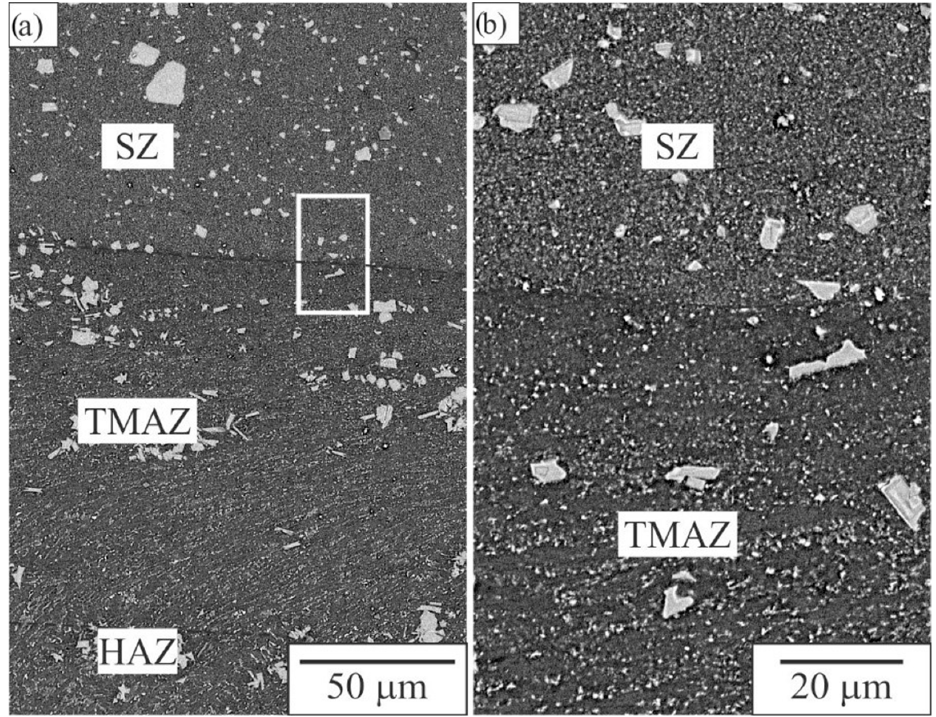
Figure 12. TMAZ below the pin of sample FSP950 (area T-NZ in Figure 2). ( a ) Transition from SZ to HAZ, ( b ) enlarged image of the interface between SZ and TMAZ.